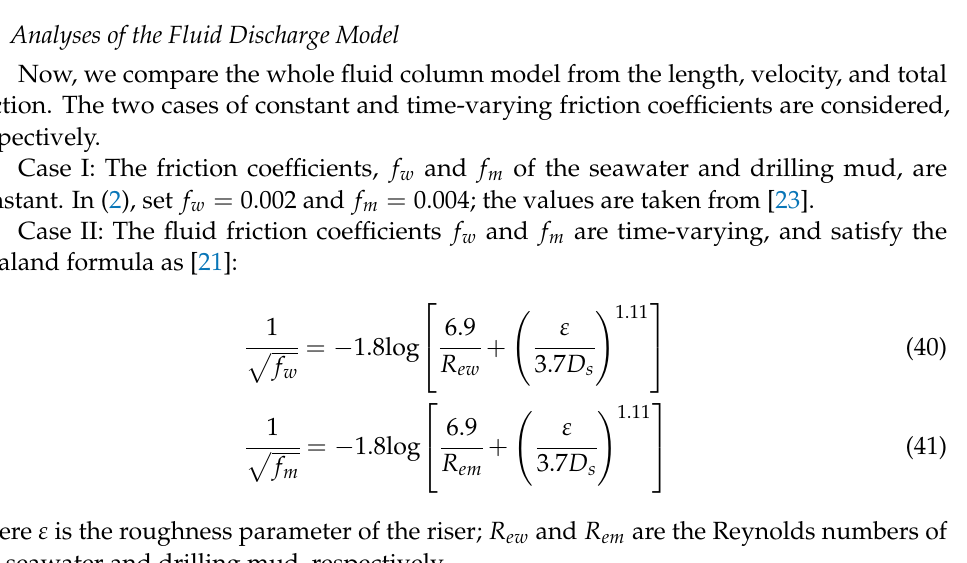
Figure 2. Response of heave motion of platform.